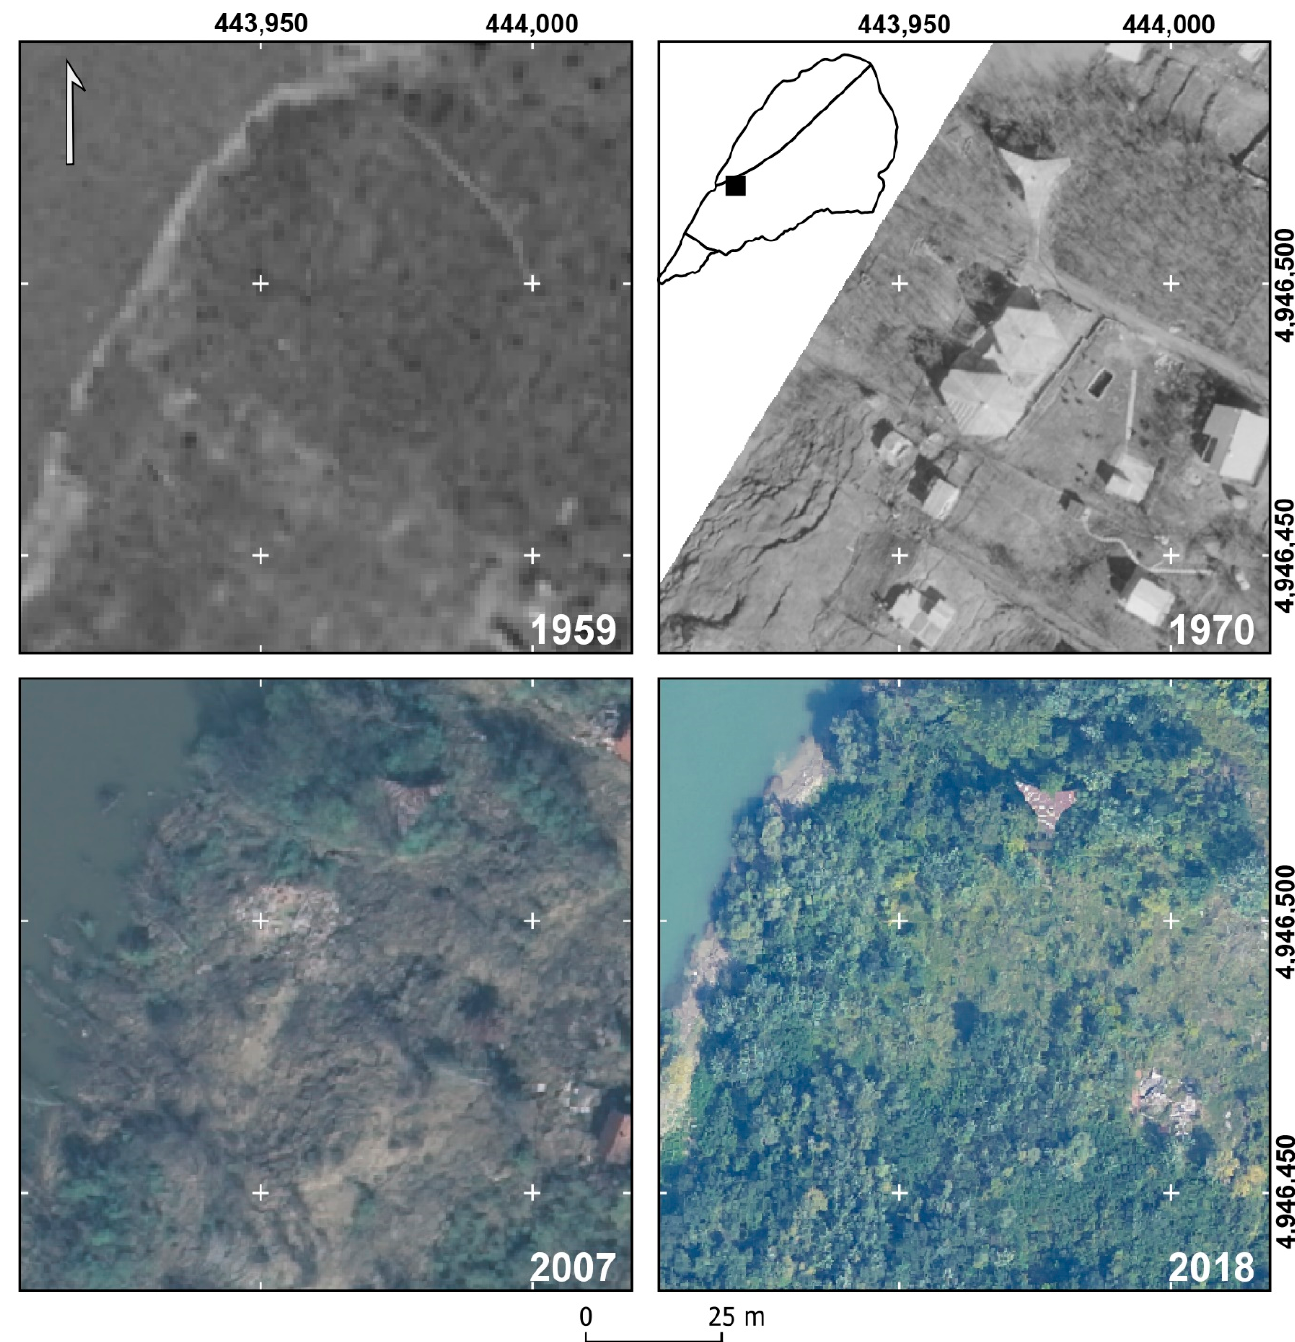
Figure 6. Details of orthophotos from the area of the “Umka” landslide from four different time epochs generated based on historical aerial photographs. The details from 2007 and 2018 show the demolition and disappearance of almost all buildings that existed during 1970.